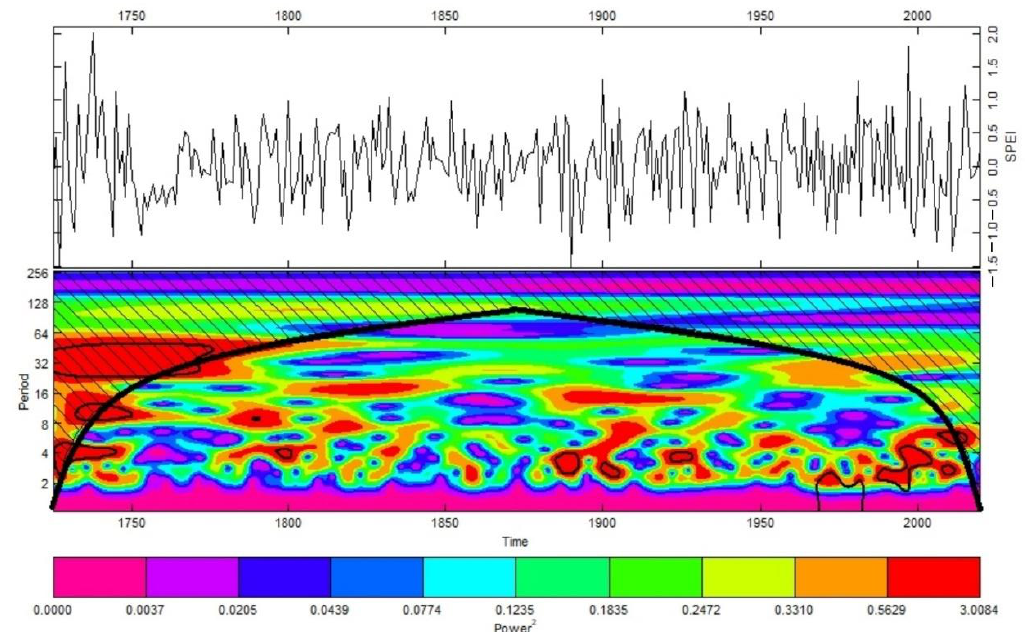
Figure 10. Wavelet coherence analysis for six-month reconstructed SPEI (February–May). Perimeters marked with a thick dark line within the cone of influence indicate significant areas ( p < 0.05).